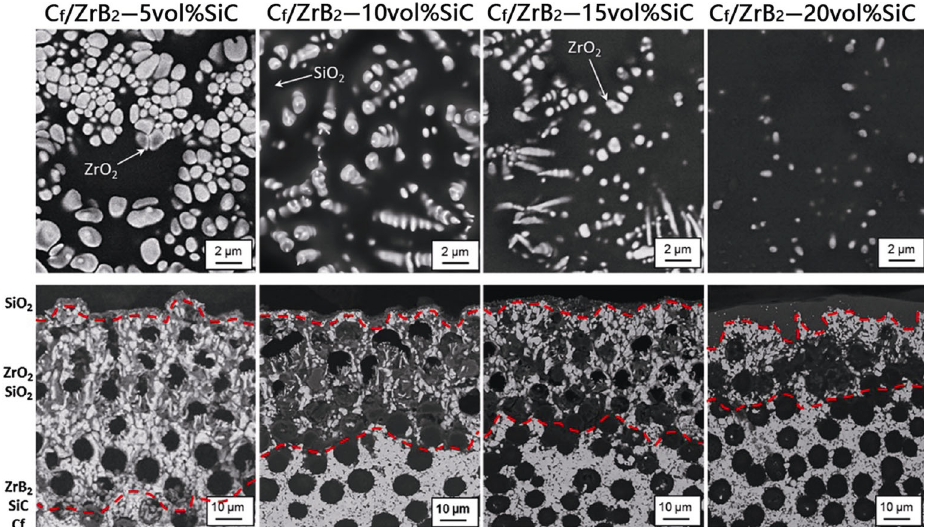
Fig. 25 Microstructure of the surface (top) and cross section (bottom) of C f /ZrB 2 –SiC with different SiC contents after oxidation at 1650 . ℃ Reproduced with permission from Ref. [216], © Elsevier Ltd.